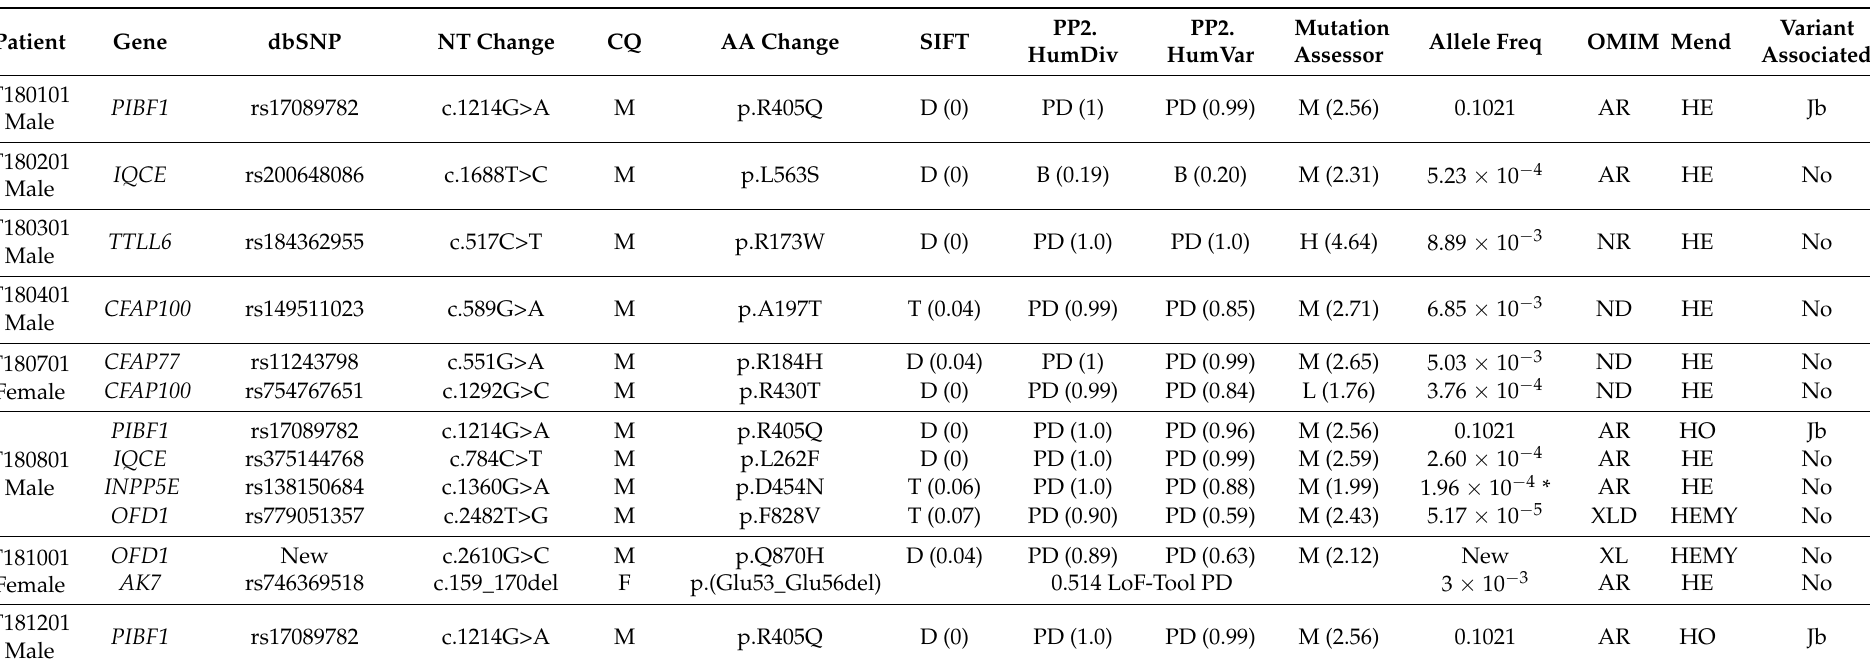
Table 3. Genetic anomalies in non-motile cilia genes in TGA. Missense, splicing, and nonsense anomalies of ciliary genes found in patients with transposition of the great